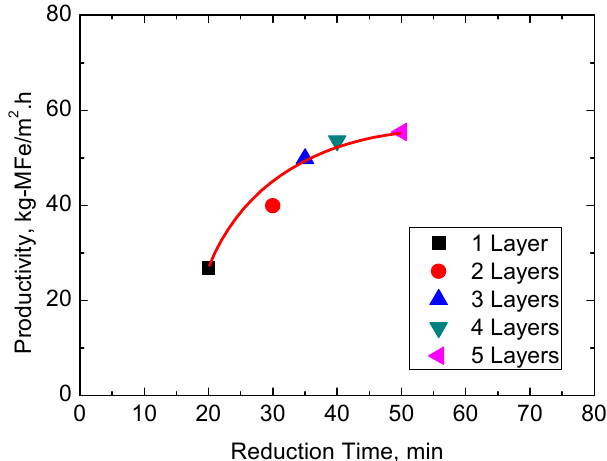
Figure 14. Maximum productivity of metallic iron and corresponding reduction time for certain pellets layers.